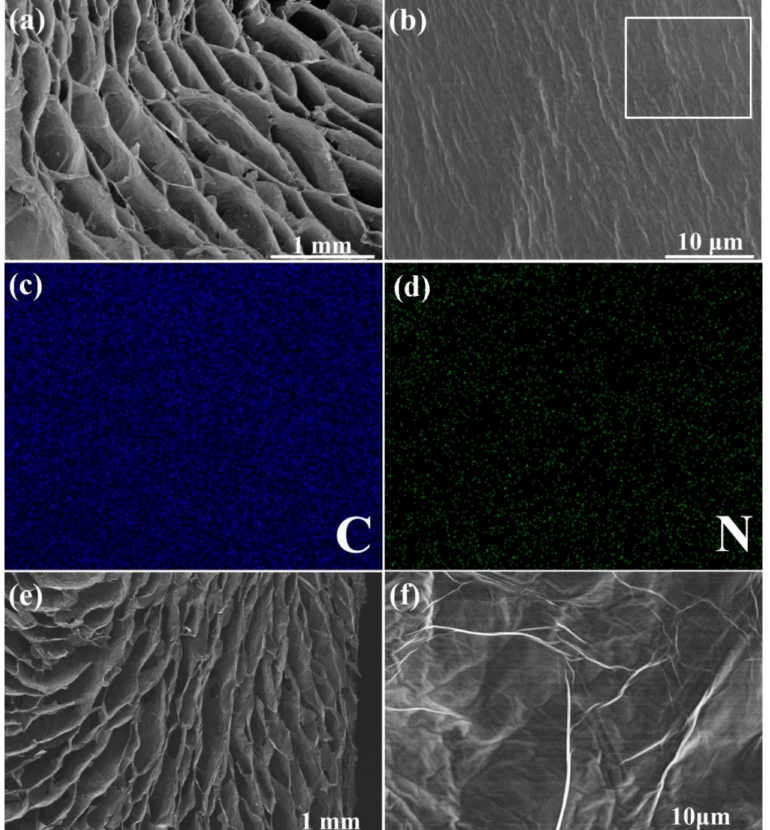
Figure 4. Scanning electron microscopy (SEM) images of ( a , b ) rGO/polyamic acid (PAA) aerogel; energy-dispersive spectroscopy (EDS) element mapping images of ( c ) C and ( d ) N in the selected area in ( b ); SEM images of ( e , f ) g-rGO/PI